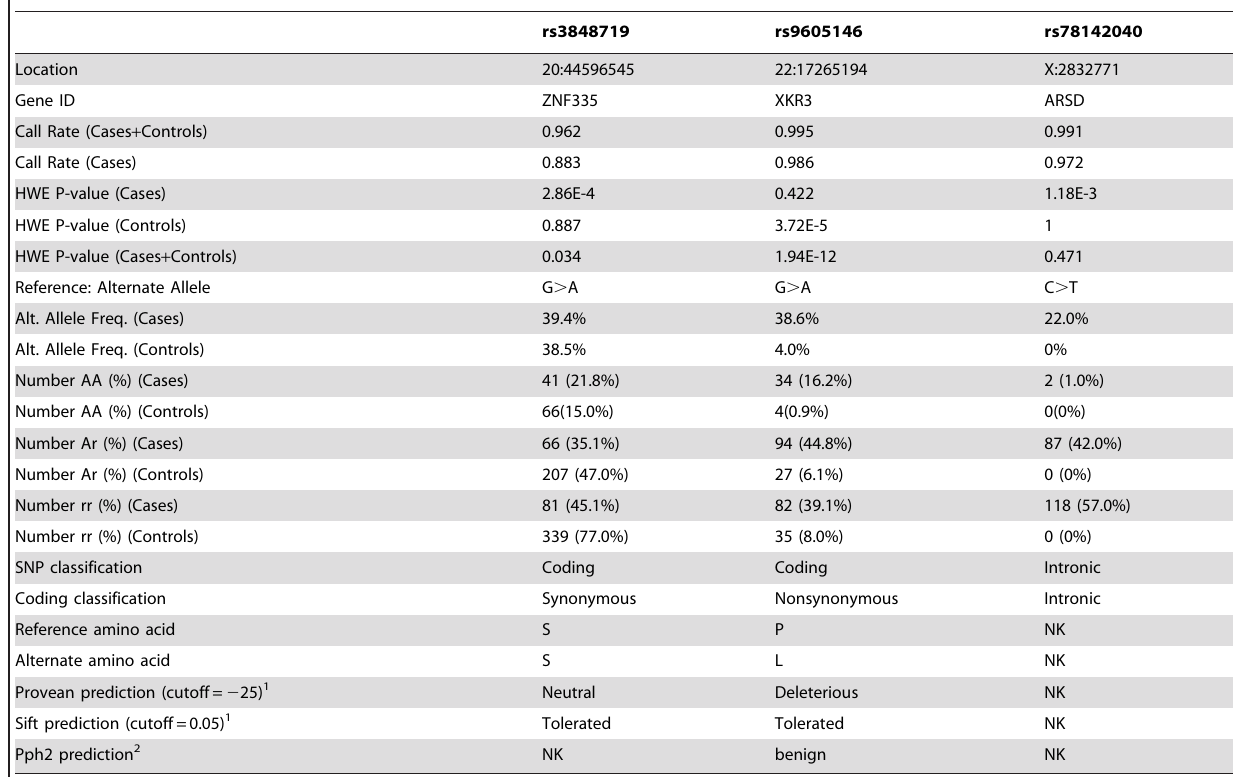
Table 4. Profile of 3 SNPs.